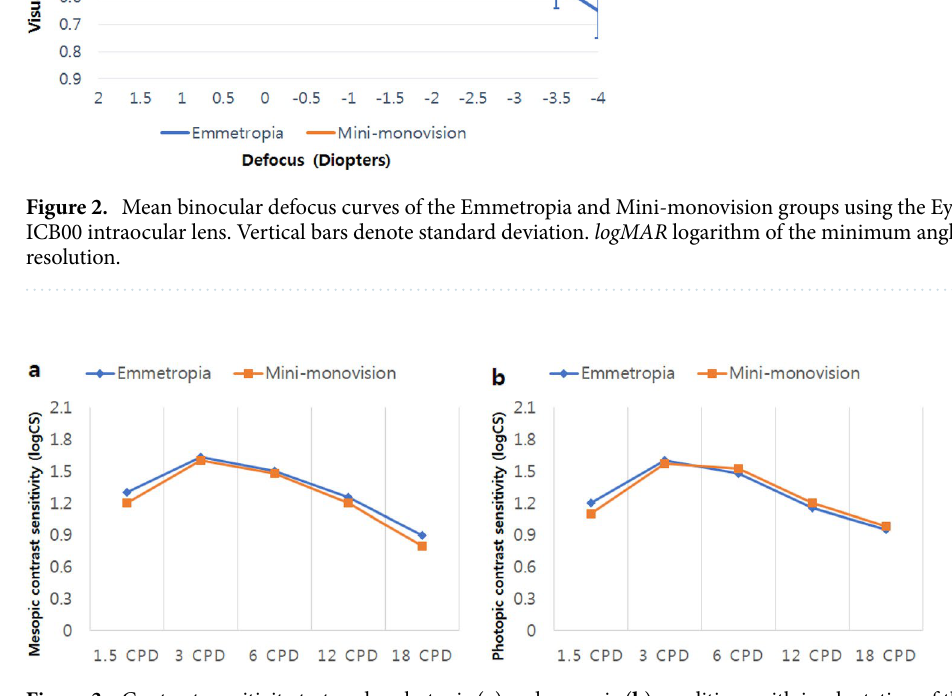
Figure 3. Contrast sensitivity test under photopic ( a ) and mesopic ( b ) conditions with implantation of the Eyhance ICB00 intraocular lens. CPD cycles per degree, logCS log contrast sensitivity.